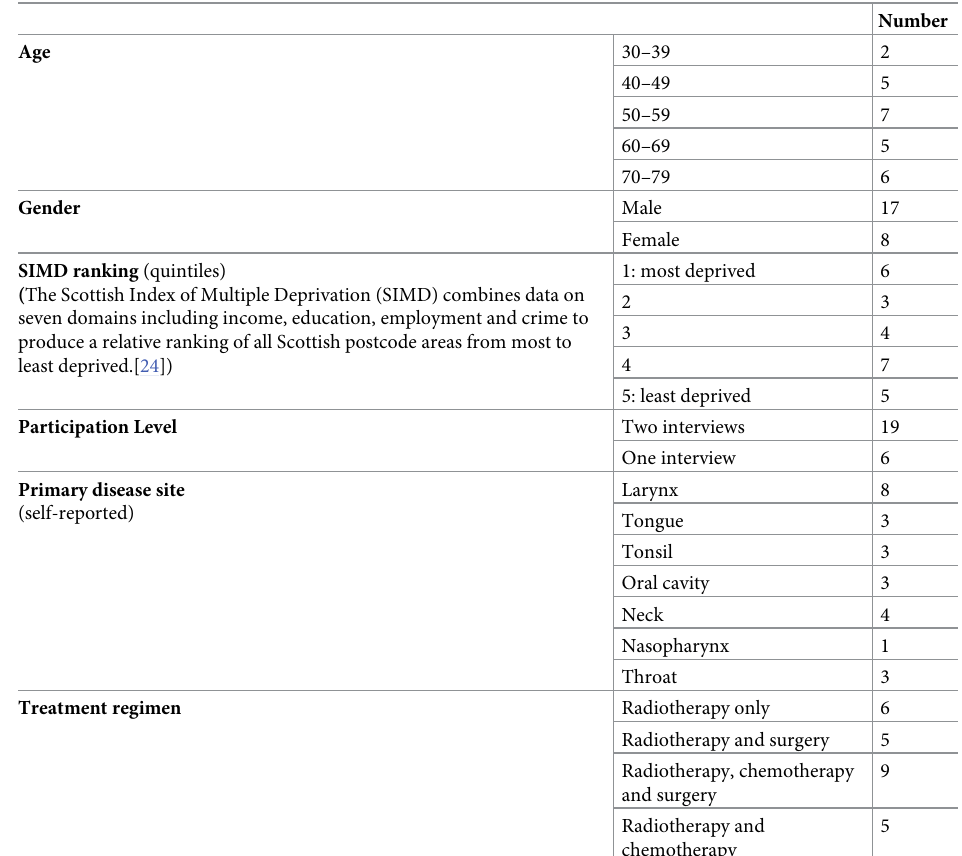
Table 1. Sample characteristics.